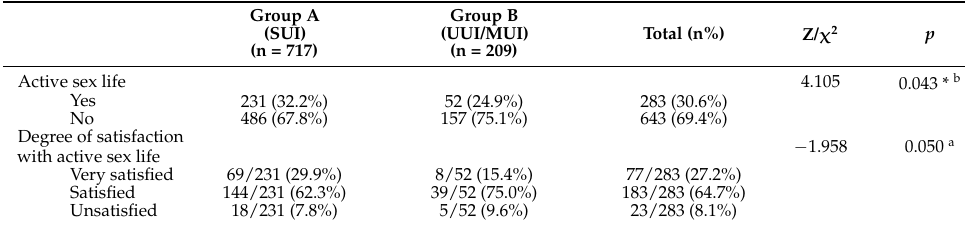
Table 5. Comparison of the general sex life of elderly women in Group A and Group